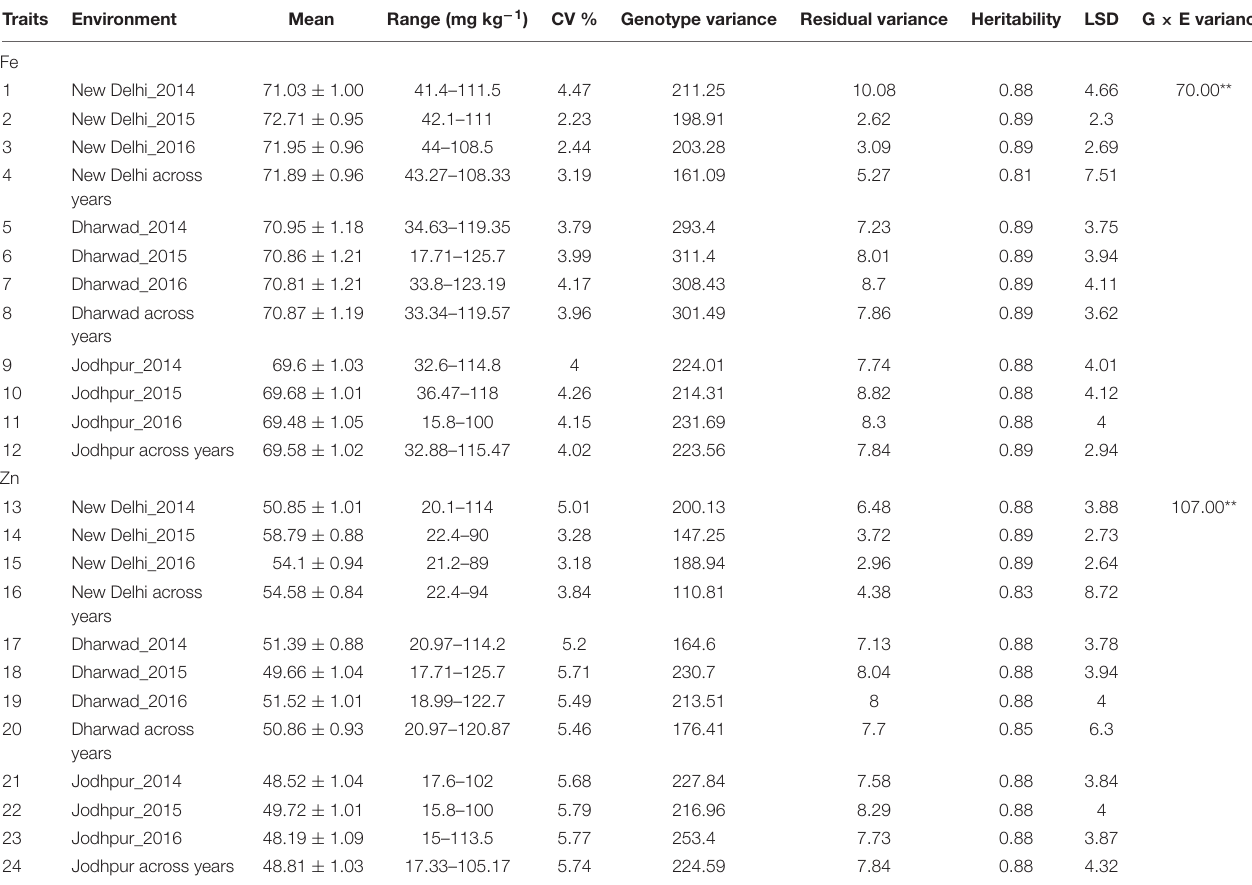
TABLE 4 | Estimates of mean, variance components (2014, 2015, and 2016), broad-sense heritability and LSD at Delhi, Dharwad, and Jodhpur for grain Fe and Zn content in RILs. Traits